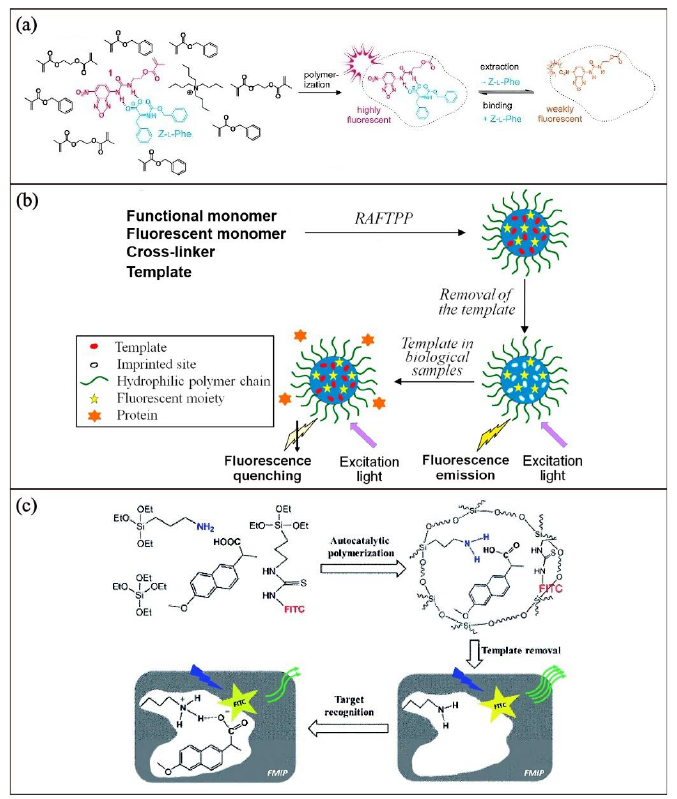
Figure 3. Schematic illustration of the synthesis of ( a ) fluorescent MIP for N-carbobenzyloxy-l-phenylalanine detection. Adapted with permission [56]. Copyright 2013, Wiley-VCH. ( b ) Hydrophilic fluorescent tetracycline-imprinted MIP nanoparticles for drug sensing. Adapted with permission [59]. Copyright 2015, Elsevier. ( c ) Fluorescent MIP for naproxen sensing. Adapted with permission [60]. Copyright 2021, Royal Society of Chemistry.